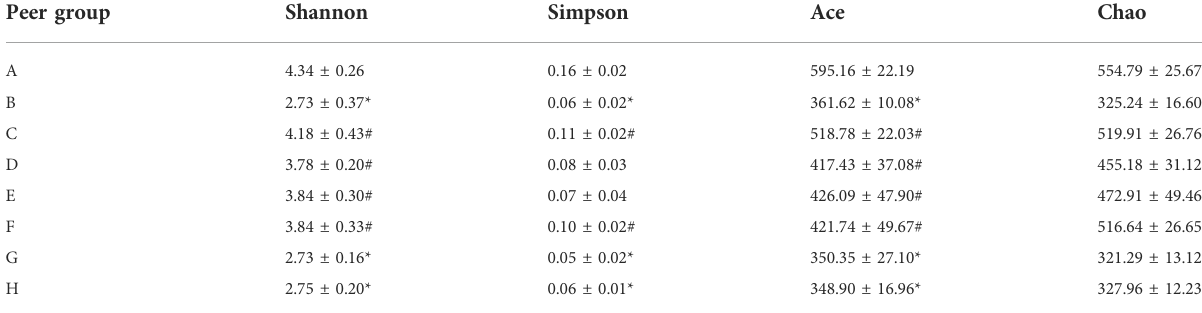
TABLE 3 Effects of Cornus of fi cinalis before and after processing on Alpha diversity index of intestinal fl ora in DN rats ( n = 6, (cid:1) x ± s ). Peer group Shannon